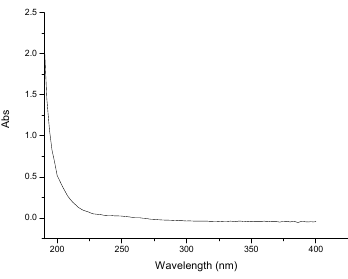
Figure 1. Ultraviolet absorption spectrum of GPMPP.